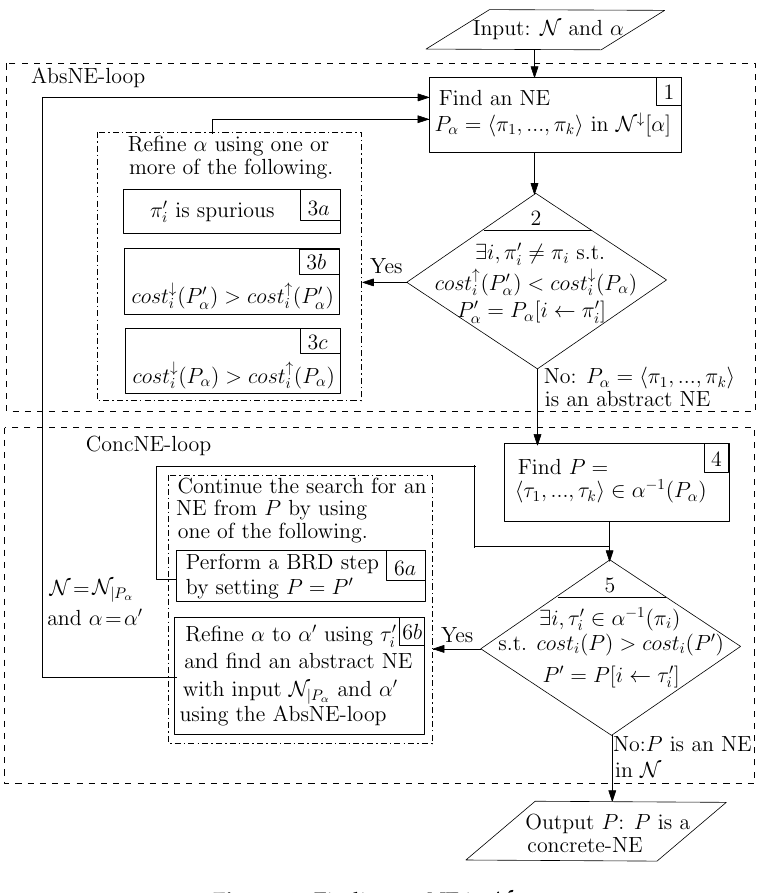
Figure 4. Finding an NE in